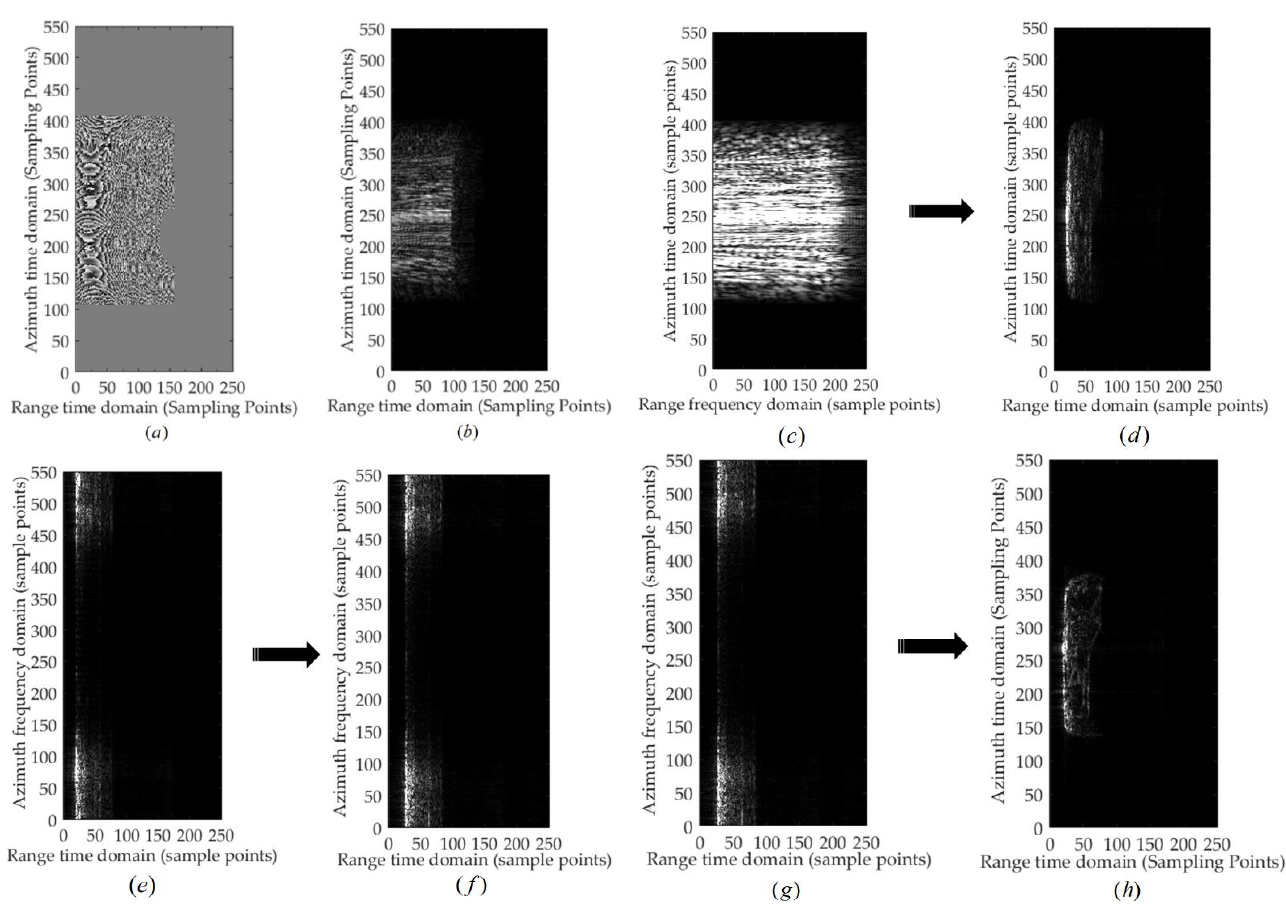
Figure 10. Imaging of the raw echo signal of car body lattices: ( a , b ) phase and magnitude of the raw echo signal; ( c , d ) before and after range compression; ( e , f ) before and after range cell migration correction; ( g , h ) azimuth compression and focus imaging.